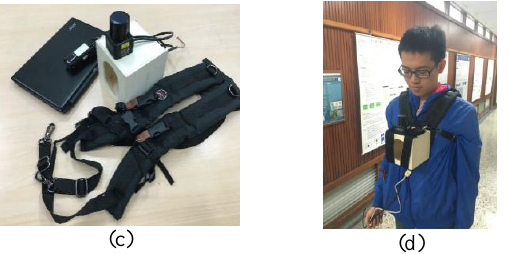
Figure 7. The indoor MMS using handheld approach and chest package. (a) shows payload for handheld approach; (b) shows actual operation for handheld approach; (c) shows payload for chest package and (d) shows actual operation for chest package